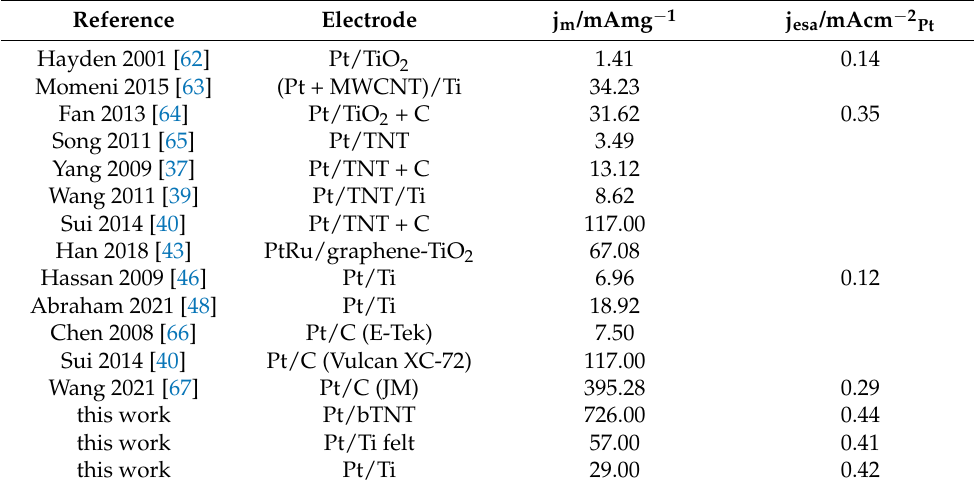
Table 1. MOR voltammetric peak current densities referred to methanol concentration of 0.5 M and potential scan rate of 5 mV s − 1